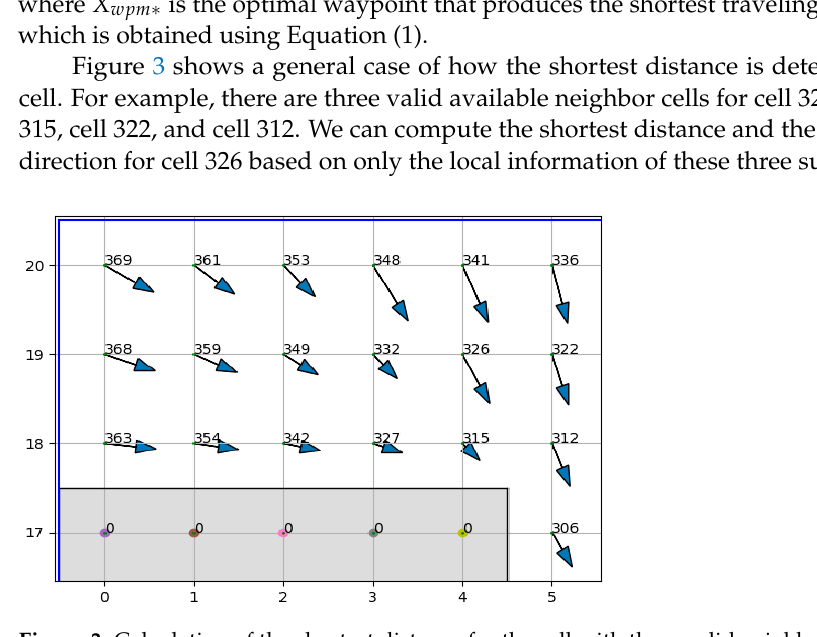
Figure 3. Calculation of the shortest distance for the cell with three valid neighbors available.